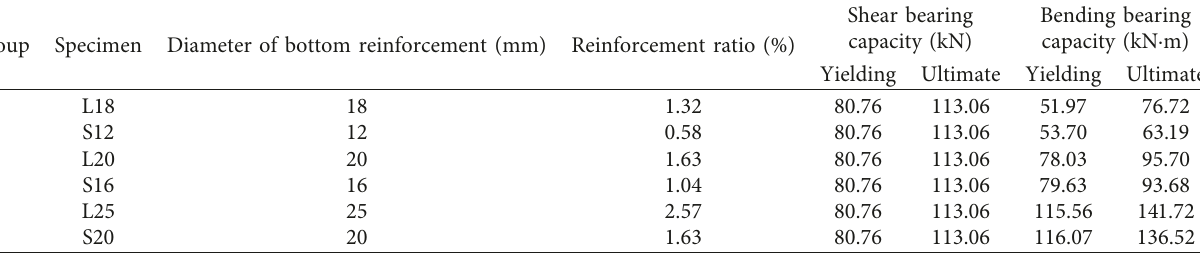
Table 4: Design parameters of the specimens.